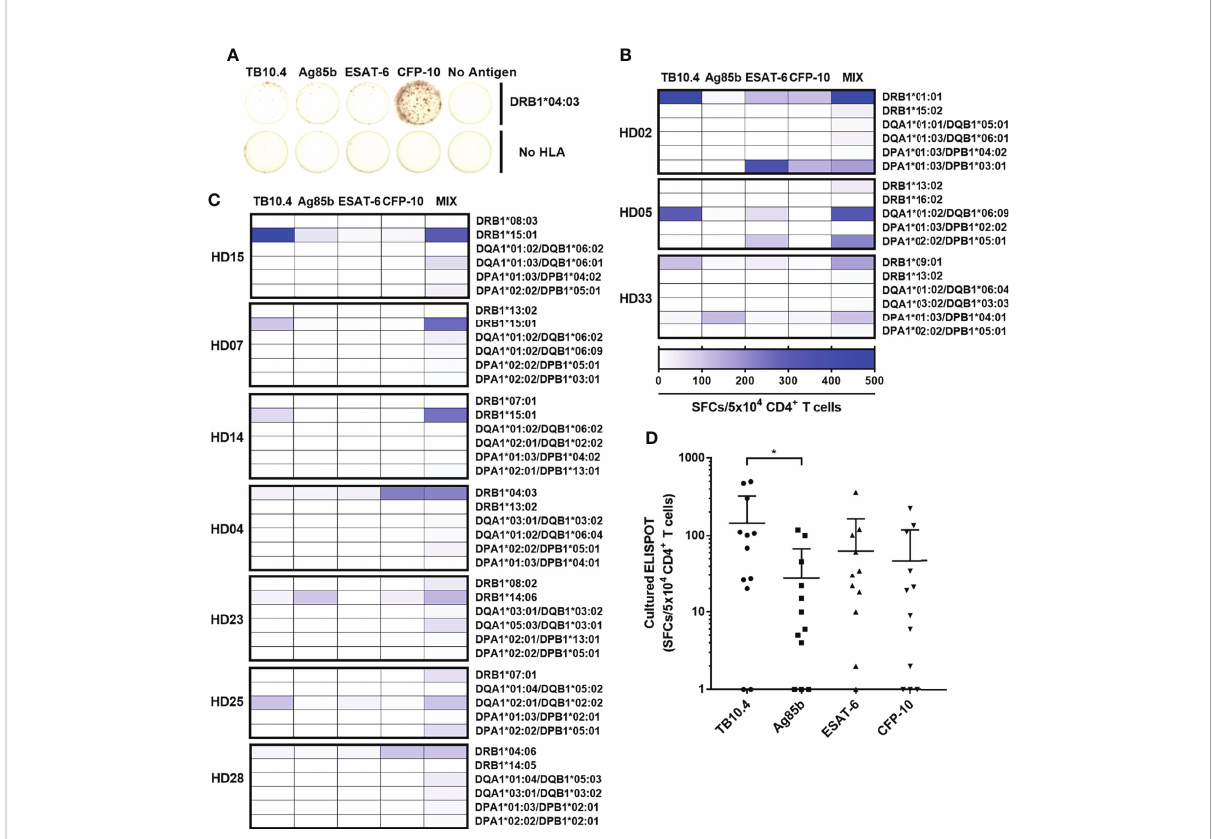
FIGURE 5 CD4 + T cell responses to each M. tuberculosis antigens TB10.4, Ag85b, ESAT-6, and CFP-10 by an HLA class II allotype. (A) Representative cultured ELISPOT to each antigen in HD04. CD4 + T cell responses by two allotypes (B) or an allotype (C) in a donor that showed a positive response were measured individually to TB10.4, Ag85b, ESAT-6, CFP-10, and a mixture of antigens. (D) Distribution of CD4 + T cell responses to each M. tuberculosis antigens. Statistical analysis was performed using Welch ’ s t-test. * p = 0.0373. Error bars present mean ± standard